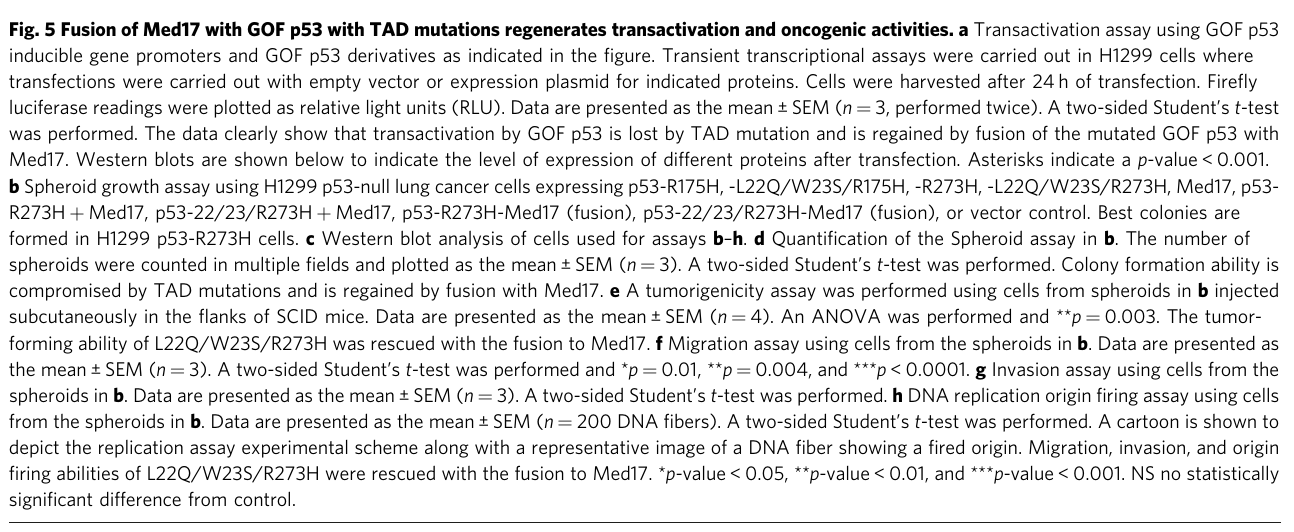
depict the replication assay experimental scheme along with a representative image of a DNA fi ber showing a fi red origin. Migration, invasion, and origin fi ring abilities of L22Q/W23S/R273H were rescued with the fusion to Med17. * p -value < 0.05, ** p -value < 0.01, and *** p -value < 0.001. NS no statistically signi fi cant difference